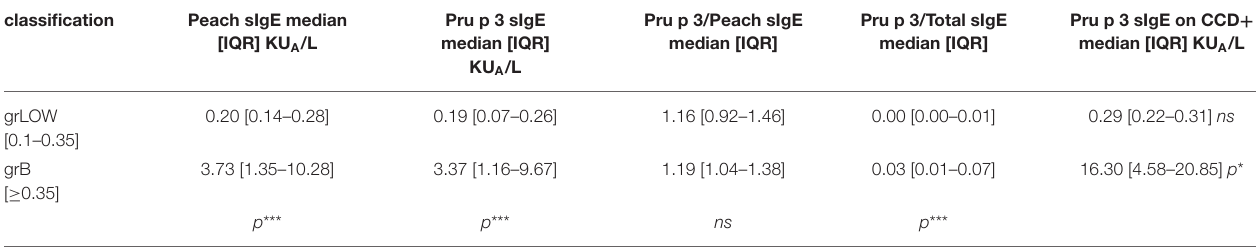
TABLE 2 | Pru p 3 sIgE values distribution.